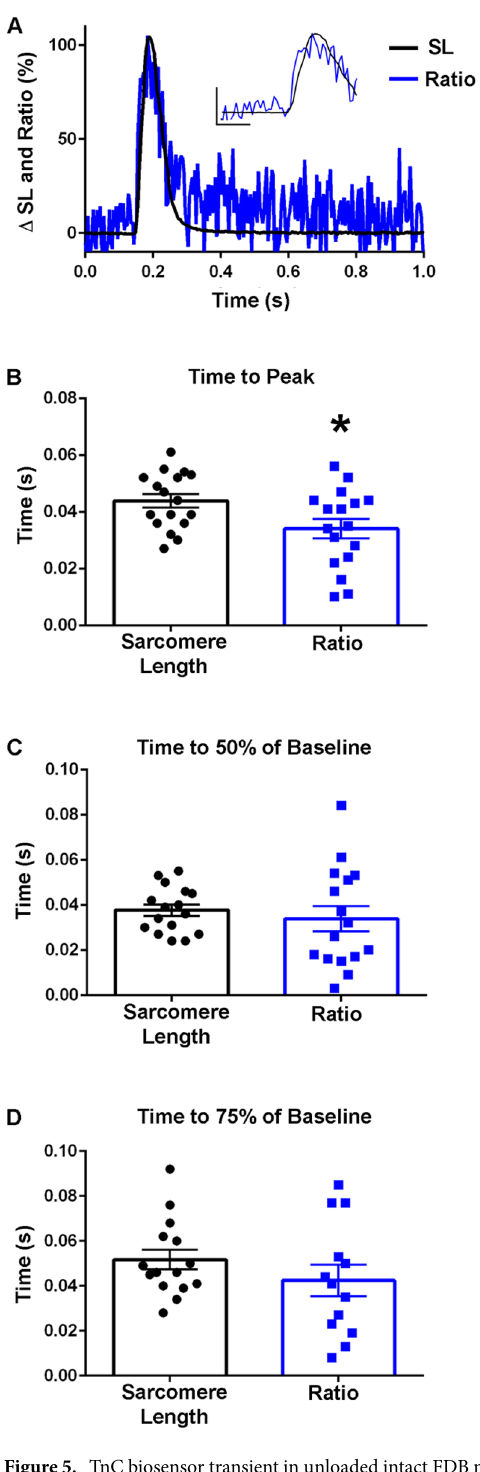
Figure 5. TnC biosensor transient in unloaded intact FDB myofibers at room temperature. ( A ) Normalized traces (0–100%) of an ensemble average of biosensor ratio fluorescence (blue) and sarcomere length (black) dynamics which demonstrates the biosensor ratio transient peak precedes the peak of the sarcomere length transient. Inset shows same data and serves to highlight the differences of the peak timing (y-axis represents a 50% change from baseline, x-axis represents 0.10 s). ( B ) Summary statistics for time to peak for the biosensor ratio and sarcomere length indicate peak activation of the biosensor ratio (0.0341 ± 0.0034 s) occurred significantly before the peak sarcomere length change (0.0438 ± 0.0024) s (n = 17 myofibers from 11 animals in each group). ( C ) Summary statistics for the time to 50% of baseline for the biosensor ratio and sarcomere length demonstrated no significant difference between the ratio or sarcomere length (n = 16 myofibers from n = 11 animals in each group). ( D ) Summary statistics for the time to 75% of baseline for the biosensor fluorescence ratio and sarcomere length changes showed no significant difference in the relaxation dynamics of the biosensor and sarcomere length (Sarcomere length: n = 15, Ratio: n = 13 from n = 9 animals). Myofibers measured at room temperature with 0.2 Hz stimulation. Mean ± S.E.M. are presented, * P <